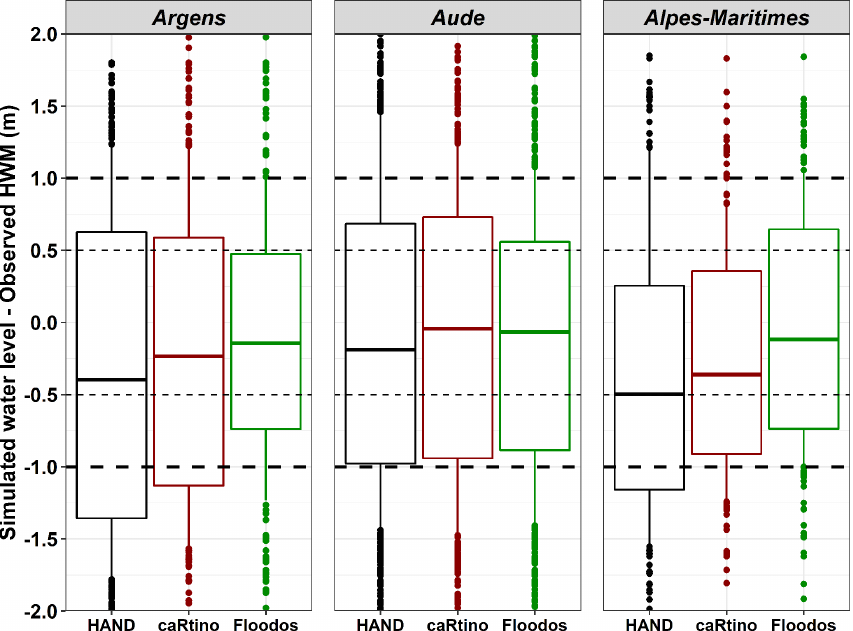
Figure 6. Comparison of simulated water levels and observed high water marks (HWMs) for the three methods and the three events. The box plots represent, respectively, the 5% and 95% (whiskers) and the 15% and 85% quantiles (boxes).